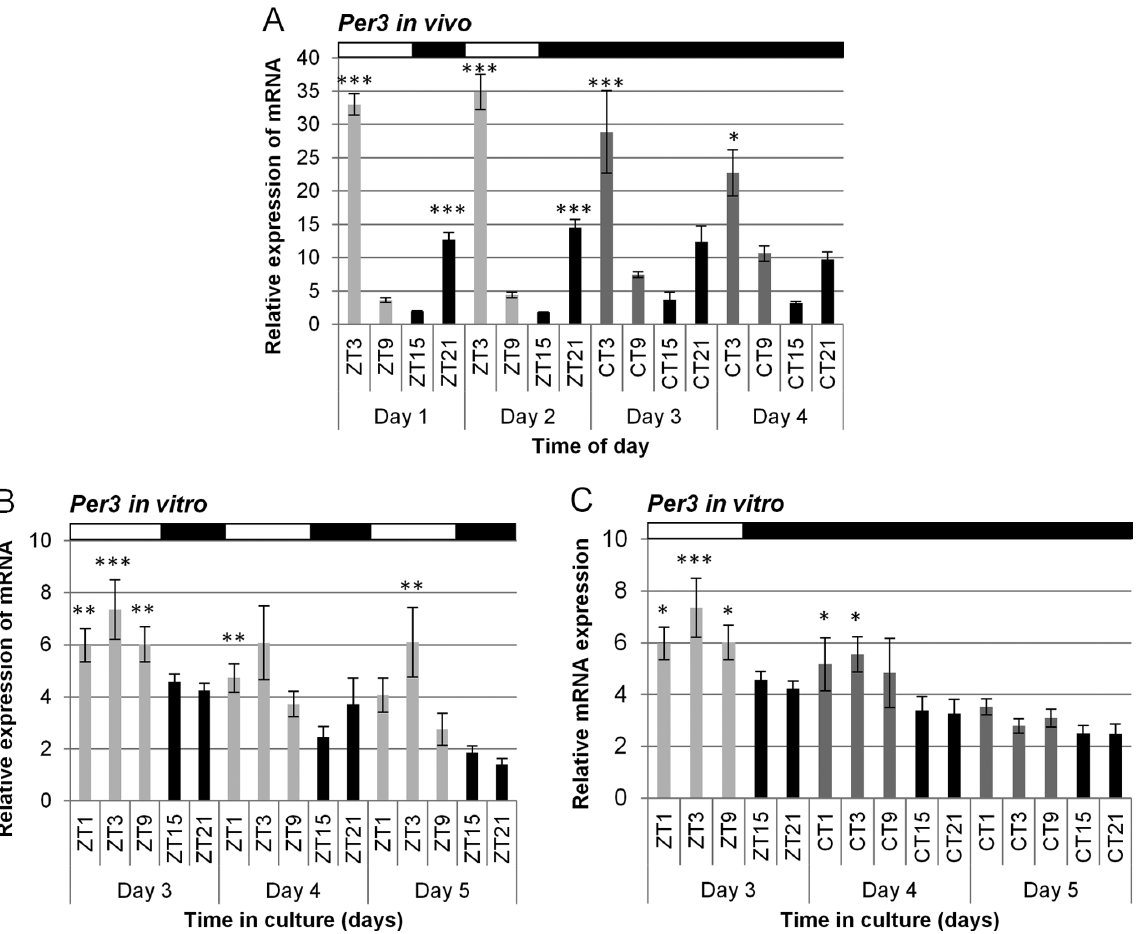
Figure 1. Per3 is a highly rhythmic circadian clock gene in whole brains invivo and invitro. A) Zebrafish were kept on 2 days of 14:10 LD followed by 2 days of DD, and brains dissected at the times indicated. RNA was extracted and qPCR was performed to evaluate the relative expression of per3 mRNA. In LD there was a peak at ZT3 and trough at ZT15 (p , 0.0001, One way ANOVA, n=7–10). In DD there was also a peak at CT3 and trough at CT15 (p , 0.0001, One way ANOVA, n=3–5). The statistical significance is shown from the post-hoc Dunnett’s multiple comparison test, which used the calibrator day 1 ZT15 for LD conditions, and day 4 CT15 for DD conditions. B) Whole brains were dissected, cultured and kept on a 14:10 LD cycle for 3 days. Samples were collected at the times indicated, RNA extracted and qPCR performed to determine the expression of per3 mRNA. There was a peak at ZT3, and a trough between ZT15 and ZT 21 (p , 0.001, One-way ANOVA, n=3–4). The statistical significance is shown from the Dunnett’s multiple comparison post-hoc test are, using the trough, ZT21, on day 5 as the calibrator. C) Whole brains were dissected as above, cultured, but this time maintained on a 14:10 LD cycle for one day before being placed into constant darkness for two additional days. Samples were collected at the times indicated, mRNA extracted, and qPCR performed to measure the levels of per3 . The rhythm persisted in per3 for one cycle under free-running conditions in vitro before damping on the second cycle in the dark. The above white black bars represent the lighting conditions, with the different plotted histogram shades representing light, dark or subjective dark